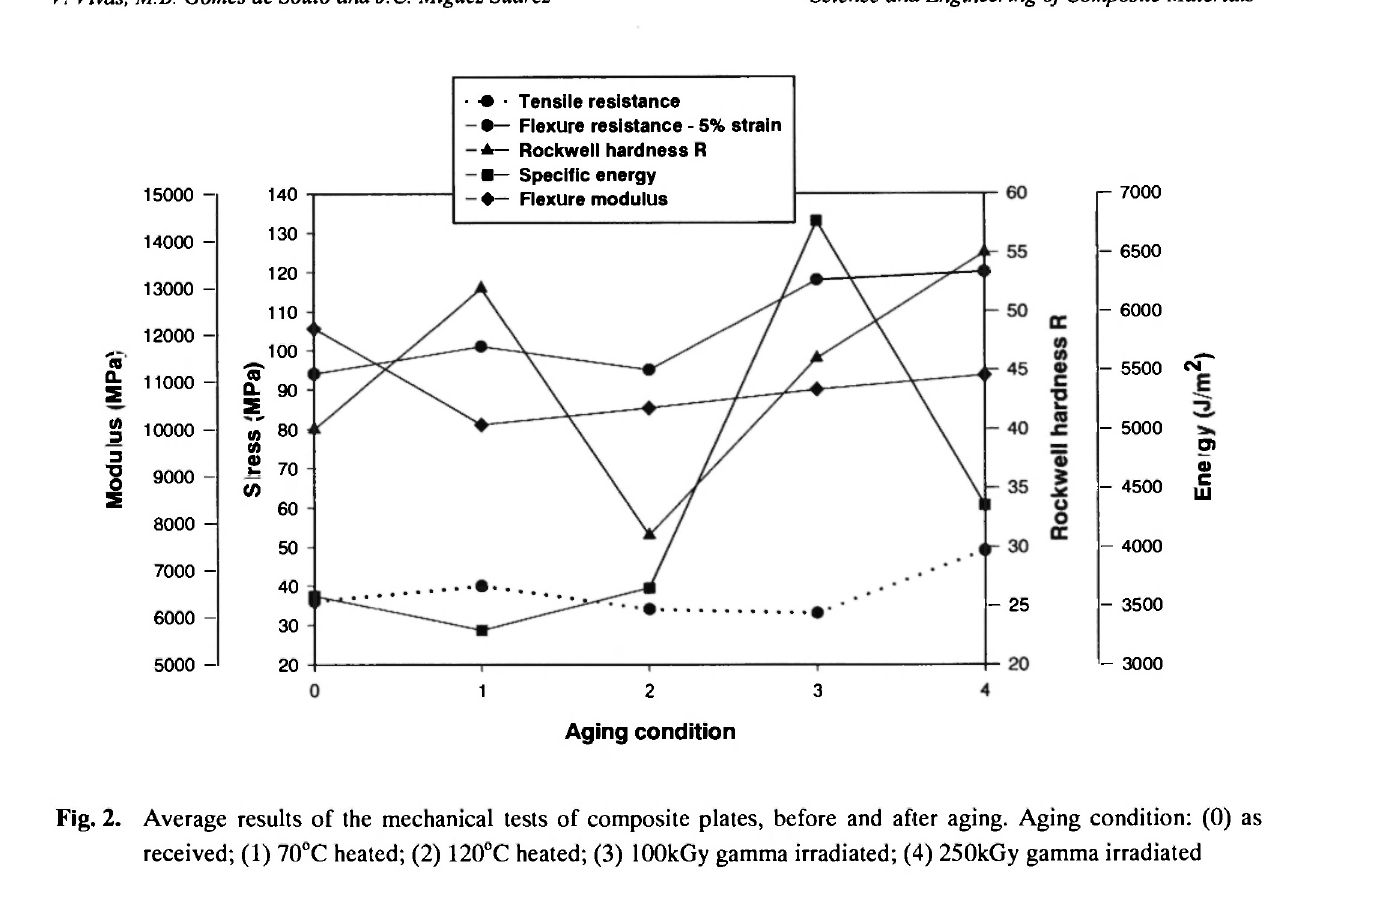
Fig. 2. Average results of the mechanical tests of composite plates, before and after aging. Aging condition: (0)